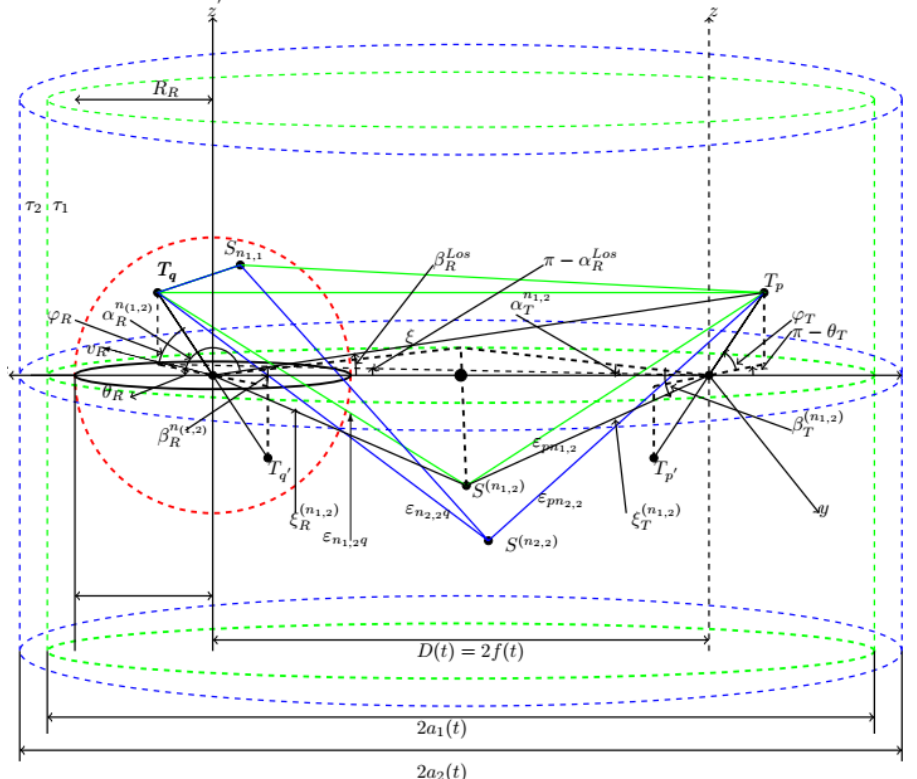
Figure 2. Proposed GBSM for one sphere and multiple elliptic cylinder model. Green solid represents tap one, blue solid represents tap two, and red dash represent the MRS